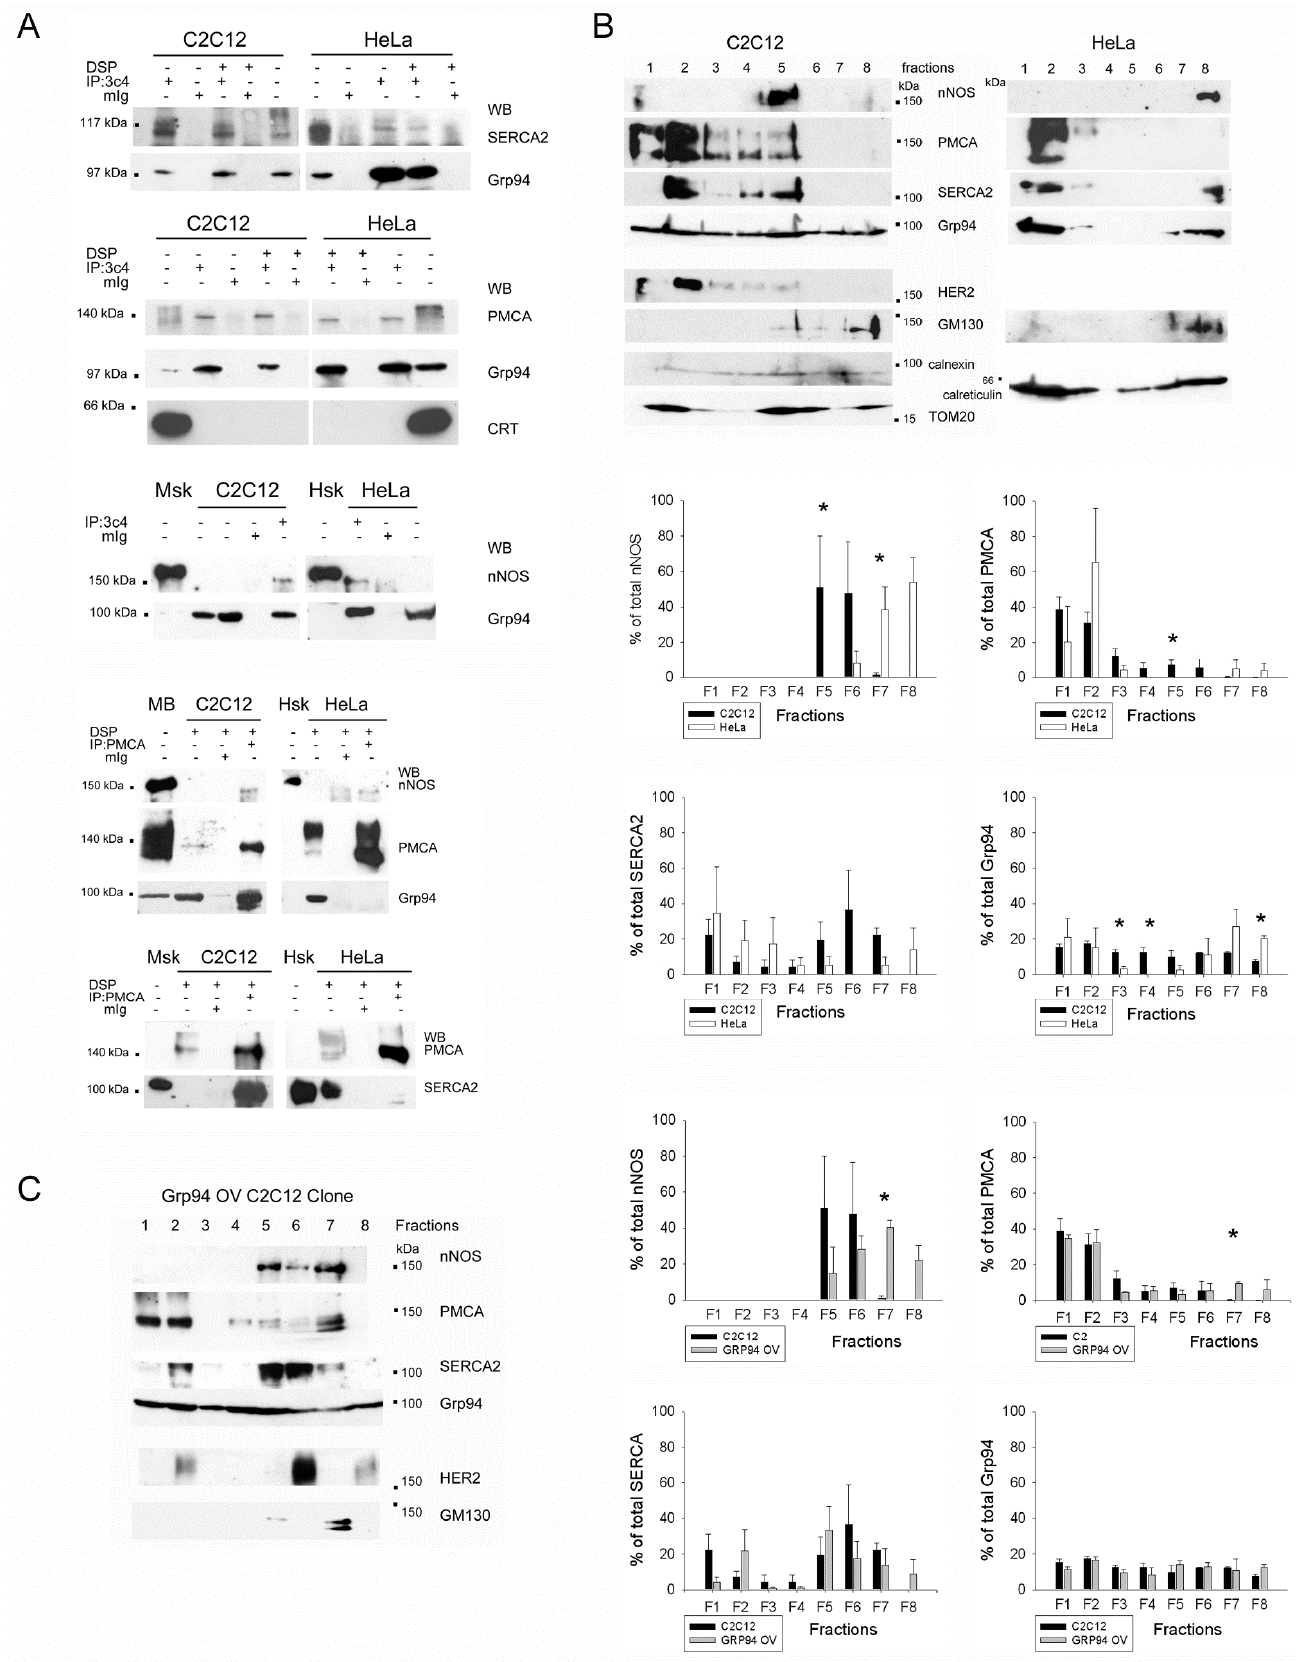
Figure 2. Figure 2. Grp94 interaction with Ca 2+ handling proteins and nNOS. ( A ) Representative Western blots of total lysates (about 30 µg) and immunoprecipitates (IP) from C2C12 and HeLa cultures using anti-Grp94 3c4 antibody (upper panel) or anti-PMCA. Non-immune mouse G immunoglob- ulins (mIg) were used for control IP. DSP indicates culture exposure to chemical cross-linking be- fore lysis and IP. About 10 µg of mouse diaphragm (Msk) or brain (MB) or human skeletal muscle (Hsk) homogenates were used as a reference for nNOS migration. ( B ) Representative Western blots (upper panels) and histograms (lower panels) of sucrose gradient fractionation of C2C12 and HeLa